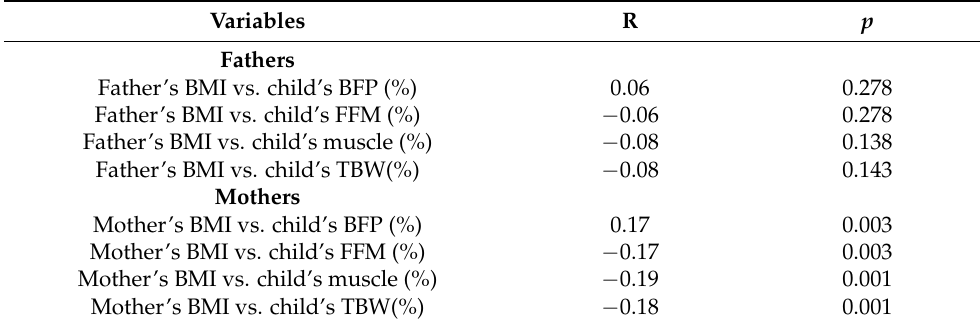
Table 8. Relationship between parents’ BMI and the parameters of the child’s body structure.